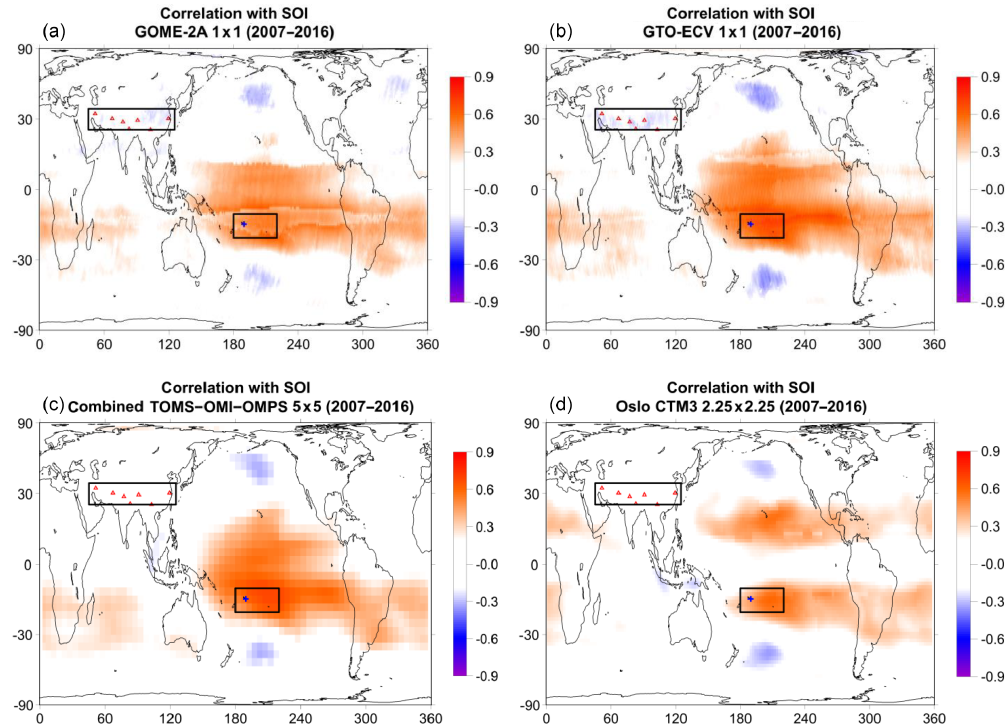
Figure 7. Map of correlation coefficients between total ozone and SOI for GOME-2A (a) , GTO-ECV (b) , TOMS–OMI–OMPS satellite data (c) , and Oslo CTM3 model simulations (d) . Rectangles correspond to the southern Pacific region (10–20 ◦ S, 180–220 ◦ E) and southern Asia region (35–45 ◦ N, 45–125 ◦ E), blue cross corresponds to the Samoa station (14.25 ◦ S, 189.4 ◦ E), and red triangles correspond to stations in southern Asia, where total ozone has been studied as to the impact of ENSO after removing variability related to the annual cycle, QBO, and solar cycle. Positive correlations are shown in red colours, while negative correlations are shown in blue colours. Only correlation coefficients above or below ± 0 . 2 are